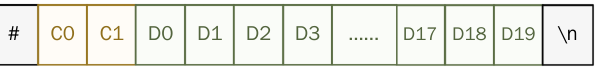
Figure 7. ECG thread